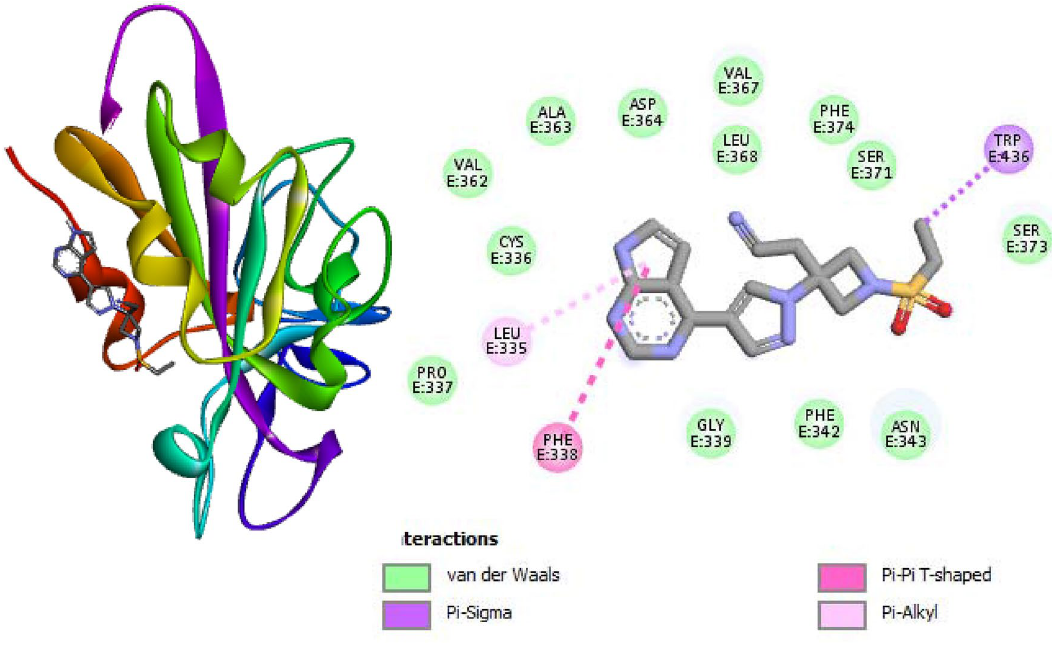
Figure 6. 3D structure of ( A ) Baricitinib in complex SARS-CoV-2 protein ( B ) 2-D representations of a docked complex of Baricitinib in complex SARS-CoV-2 protein displaying the interactions with amino acid